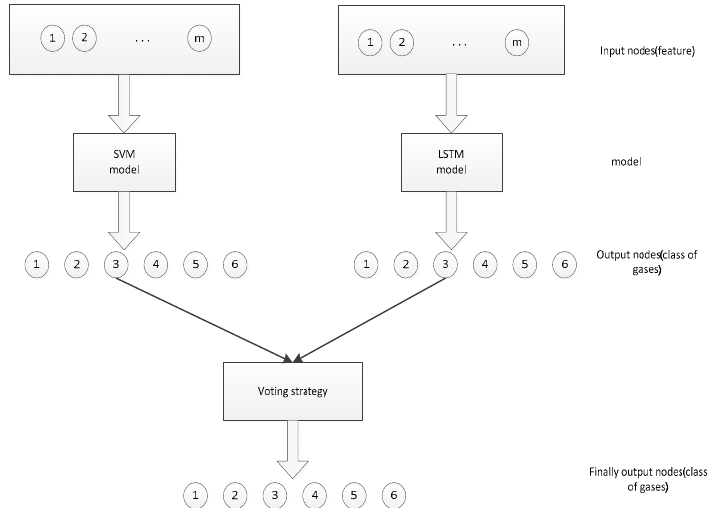
Figure 4. Input and output of two classifiers.